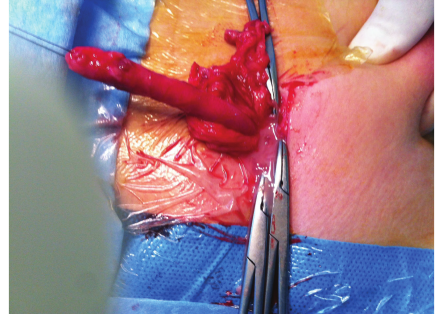
Figure 4: The herniated inflamed appendix was extracted by the inguinal